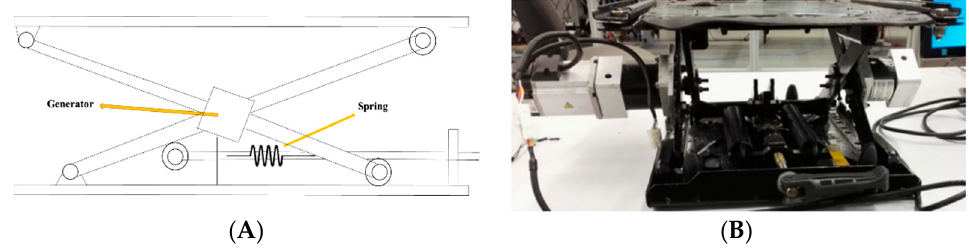
Figure 12. ( A ) Semi-active regenerative seat suspension schematic. ( B ) Seat suspension prototype [89].